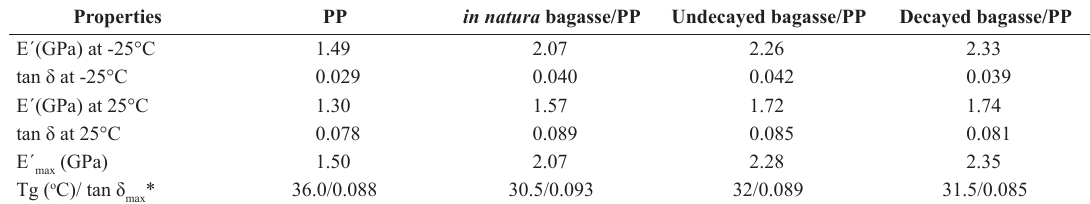
Table 4. Dynamic mechanical properties of polypropylene composites reinforced with 10 wt% of fibers with respect to neat PP. Properties